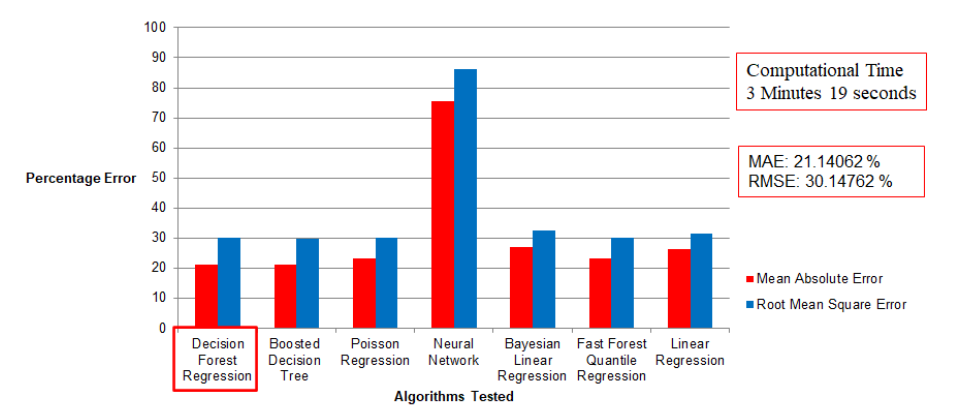
Figure 5. Regression model results for normal case.